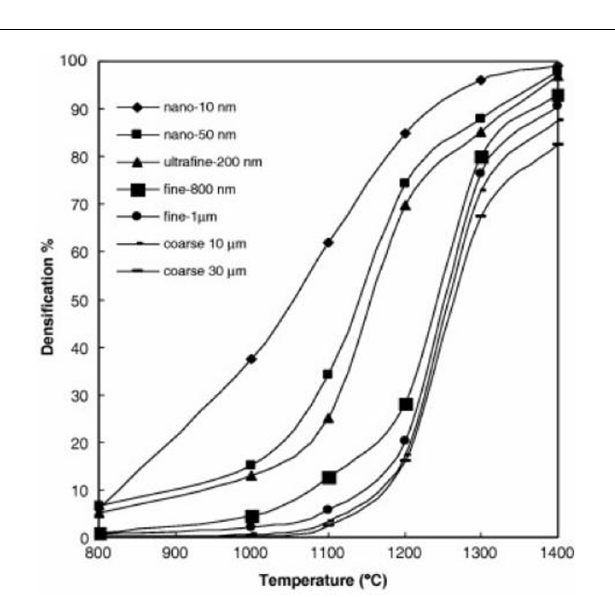
FIGURE 3 | Relationship between sintering temperature and sintering densification of powders with different initial particle sizes (Maheshwari et al., 2007) [Figure 2 of Maheshwari et al. (2007), Copyright Amer Powder Metallurgy